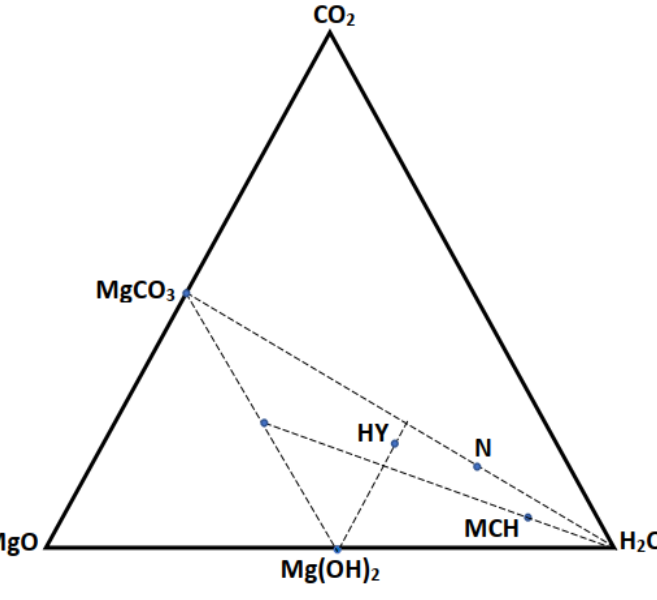
Figure 5. Phase relationship for the studied system.